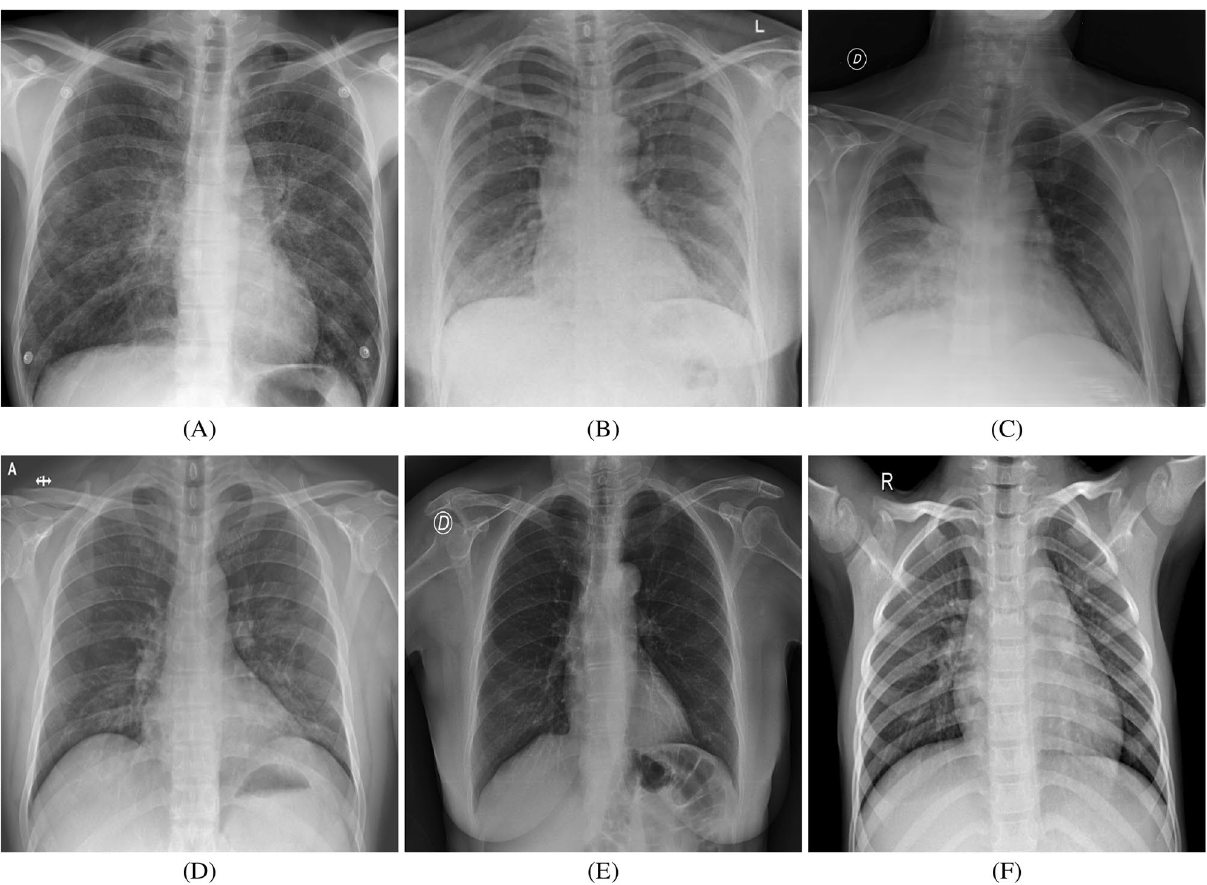
Figure 5. Examples of X-ray chest radiography images collected from COVID-19 patient and normal cases. ( A ) A COVID-19 patient case from COVID-19 open image data collection. ( B ) A COVID-19 patient case from Fig. 1 COVID-19 Chest X-ray Dataset Initiative. ( C ) A COVID-19 patient case from ActualMed COVID-19 chest X-ray dataset initiative. ( D ) A COVID-19 patient case from COVID-19 Radiography Database. ( E )